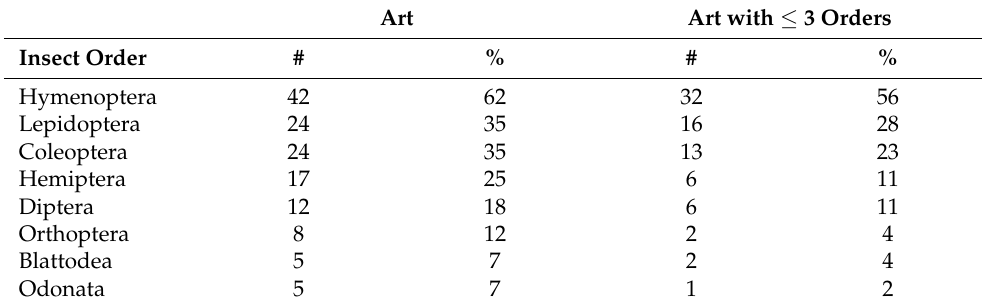
Table 2. Number and percentage of artworks addressing human-induced environmental disturbance, organized by insect order featured in the artists’ works. Each artwork potentially features more than one insect order, but each order is calculated here no more than one time per artist. Data here represent 68 of the surveyed artists (whose art has a discrete set of known, identifiable insect orders; n = 148 order associations), and then 57 of the artists whose work addressed ≤ 3 insect orders ( n = 80 order associations), to reduce bias from any artist whose work features many insect orders. Only the eight insect orders most frequently featured are included here.